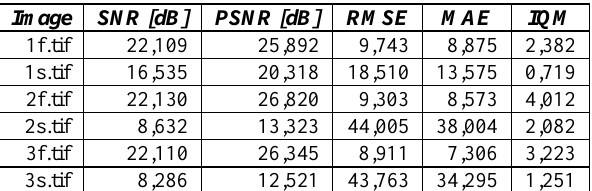
Table 3. The values of quality images in